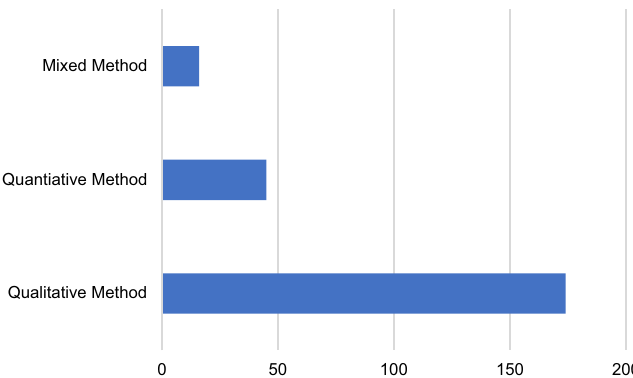
Fig. 4 An overview of research methods in empirical studies